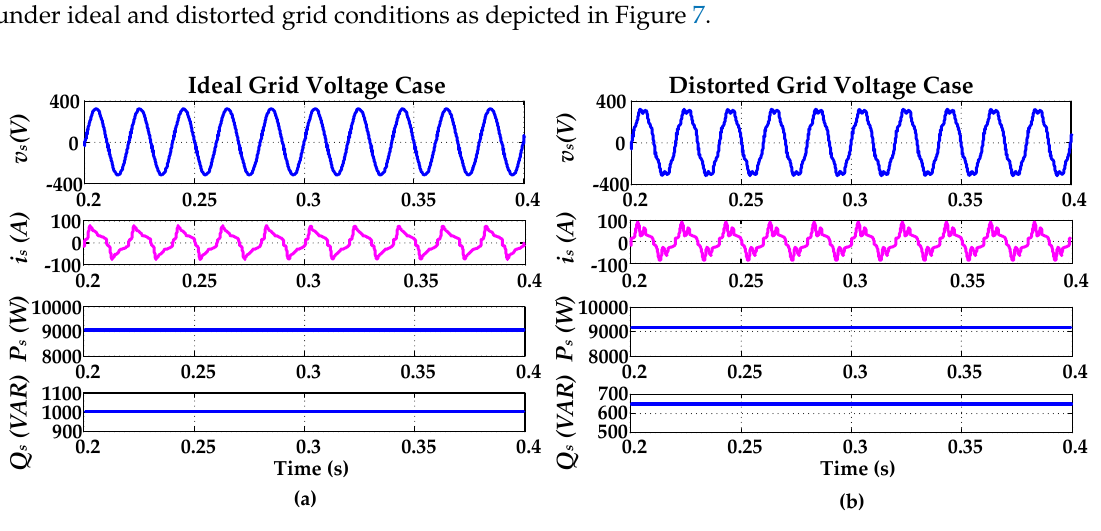
Figure 7. Simulated waveforms under MFI OFF mode; ( a ) ideal grid source voltage, current, active, and reactive power; ( b ) distorted grid source voltage, current, active, and reactive power.